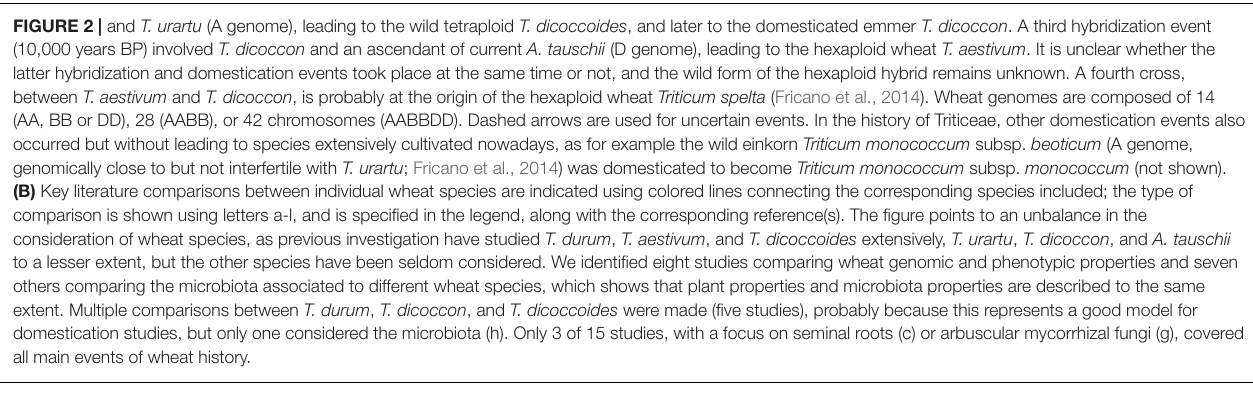
FIGURE 2 | and T. urartu (A genome), leading to the wild tetraploid T. dicoccoides , and later to the domesticated emmer T. dicoccon . A third hybridization event (10,000 years BP) involved T. dicoccon and an ascendant of current A. tauschii (D genome), leading to the hexaploid wheat T. aestivum . It is unclear whether the latter hybridization and domestication events took place at the same time or not, and the wild form of the hexaploid hybrid remains unknown. A fourth cross, between T. aestivum and T. dicoccon , is probably at the origin of the hexaploid wheat Triticum spelta (Fricano et al., 2014). Wheat genomes are composed of 14 (AA, BB or DD), 28 (AABB), or 42 chromosomes (AABBDD). Dashed arrows are used for uncertain events. In the history of Triticeae, other domestication events also occurred but without leading to species extensively cultivated nowadays, as for example the wild einkorn Triticum monococcum subsp. beoticum (A genome, genomically close to but not interfertile with T. urartu ; Fricano et al., 2014) was domesticated to become Triticum monococcum subsp. monococcum (not shown). (B) Key literature comparisons between individual wheat species are indicated using colored lines connecting the corresponding species included; the type of comparison is shown using letters a-l, and is specified in the legend, along with the corresponding reference(s). The figure points to an unbalance in the consideration of wheat species, as previous investigation have studied T. durum , T. aestivum , and T. dicoccoides extensively, T. urartu , T. dicoccon , and A. tauschii to a lesser extent, but the other species have been seldom considered. We identified eight studies comparing wheat genomic and phenotypic properties and seven others comparing the microbiota associated to different wheat species, which shows that plant properties and microbiota properties are described to the same extent. Multiple comparisons between T. durum , T. dicoccon , and T. dicoccoides were made (five studies), probably because this represents a good model for domestication studies, but only one considered the microbiota (h). Only 3 of 15 studies, with a focus on seminal roots (c) or arbuscular mycorrhizal fungi (g), covered all main events of wheat